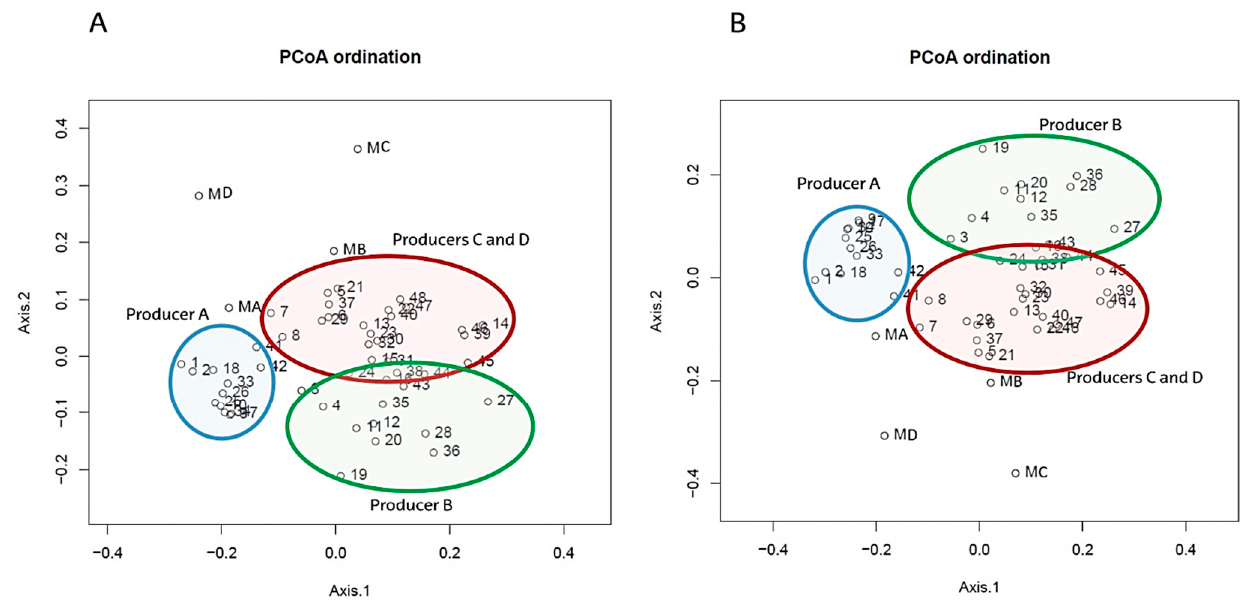
Figure 6. PCoA of bacterial beta diversity at genus rank based on Bray-Curtis ( A ) and Jaccard ( B ) dissimilarities.